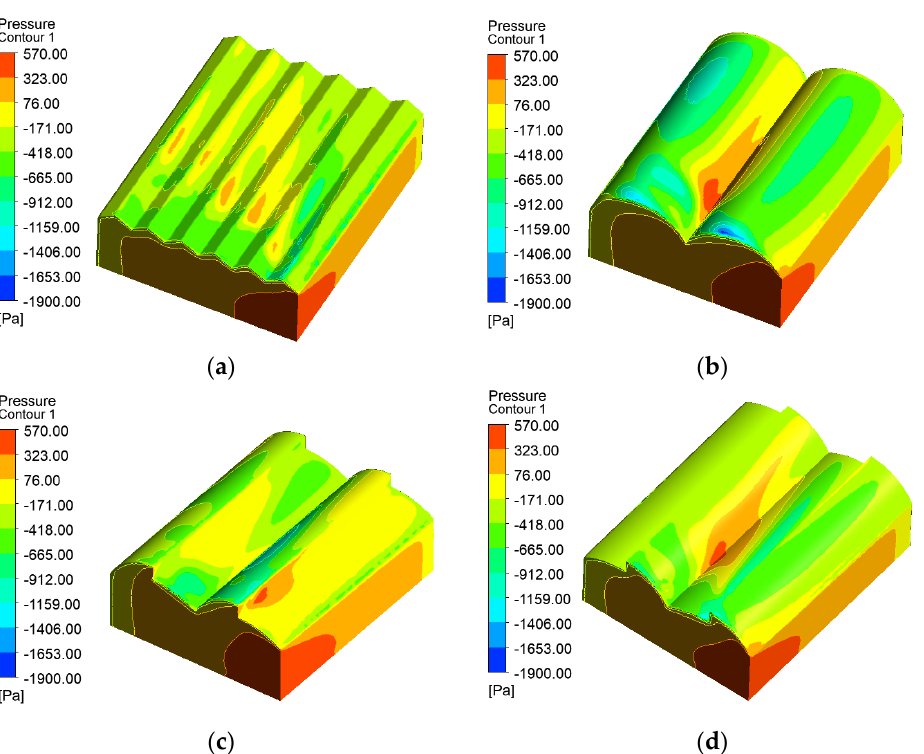
Figure 8. Counters of wind pressure distribution on the greenhouse surface in 45°-wind. ( a ) Venlo Type ( b ) Round-arch Type ( c ) Saw-tooth Type ( d ) Saw-tooth Type (135°-wind).